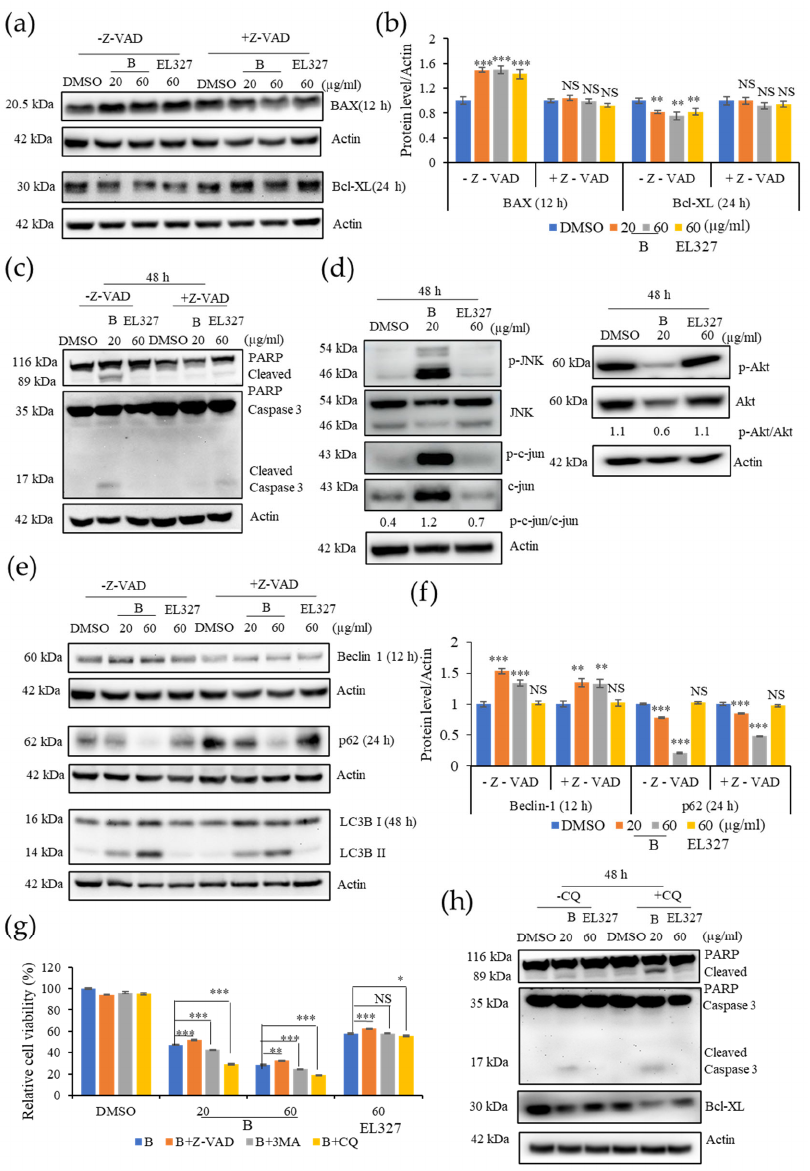
Figure 4. Inhibition of B induced autophagy increases apoptosis in Caco2 cells. ( a ) Western blot analysis of the pro ‐ apoptotic protein BAX and the anti ‐ apoptotic protein Bcl ‐ xL treated by B (20 or 60 μ g/mL) or EL000327 (60 μ g/mL) for 12 or 24 h in the presence or absence of Z ‐ VAD ‐ FMK (10 μ M). ( b ) Quantification of BAX and Bcl ‐ XL protein expressions. ( c ) Western blot of apoptotic proteins; PARP, Caspase ‐ 3treated by B (20 or 60 μ g/mL) or EL000327 (60 μ g/mL) for 48 h in the presence or absence of Z ‐ VAD ‐ FMK. ( d ) Expressions of the apoptotic signaling pathway related